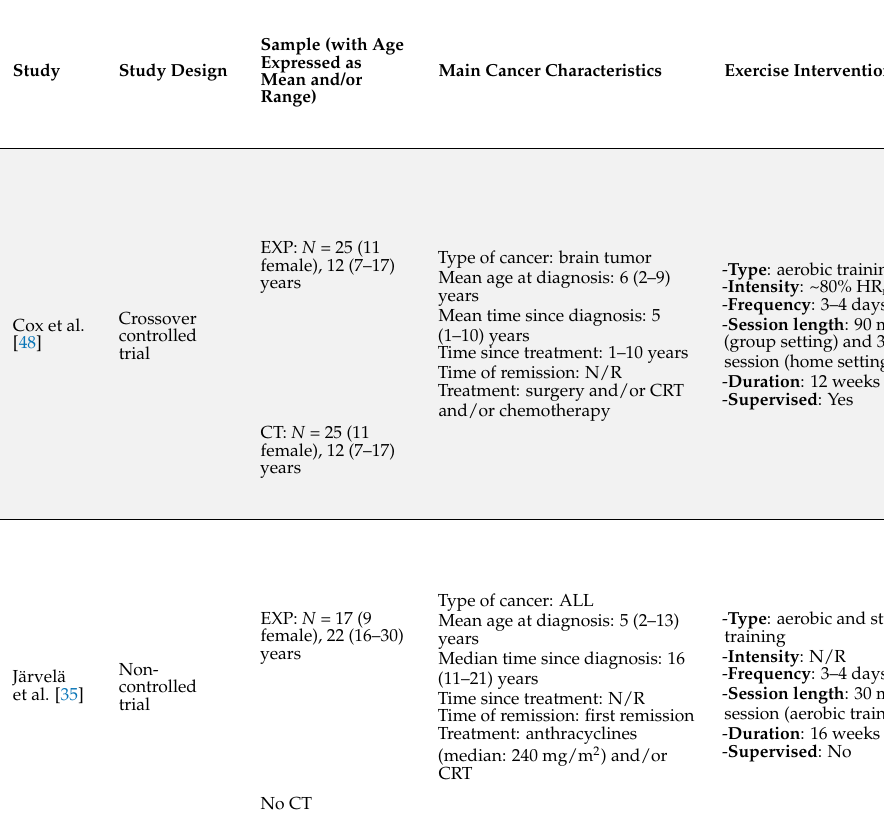
Table 3. Examples of relevant studies analyzing the effects of exercise intervention after childhood cancer